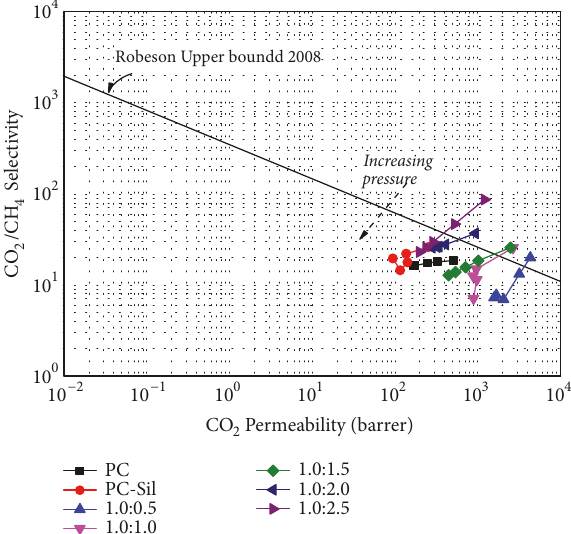
Figure 8: Comparison of membrane performance on 2008 Robe- son’s upper